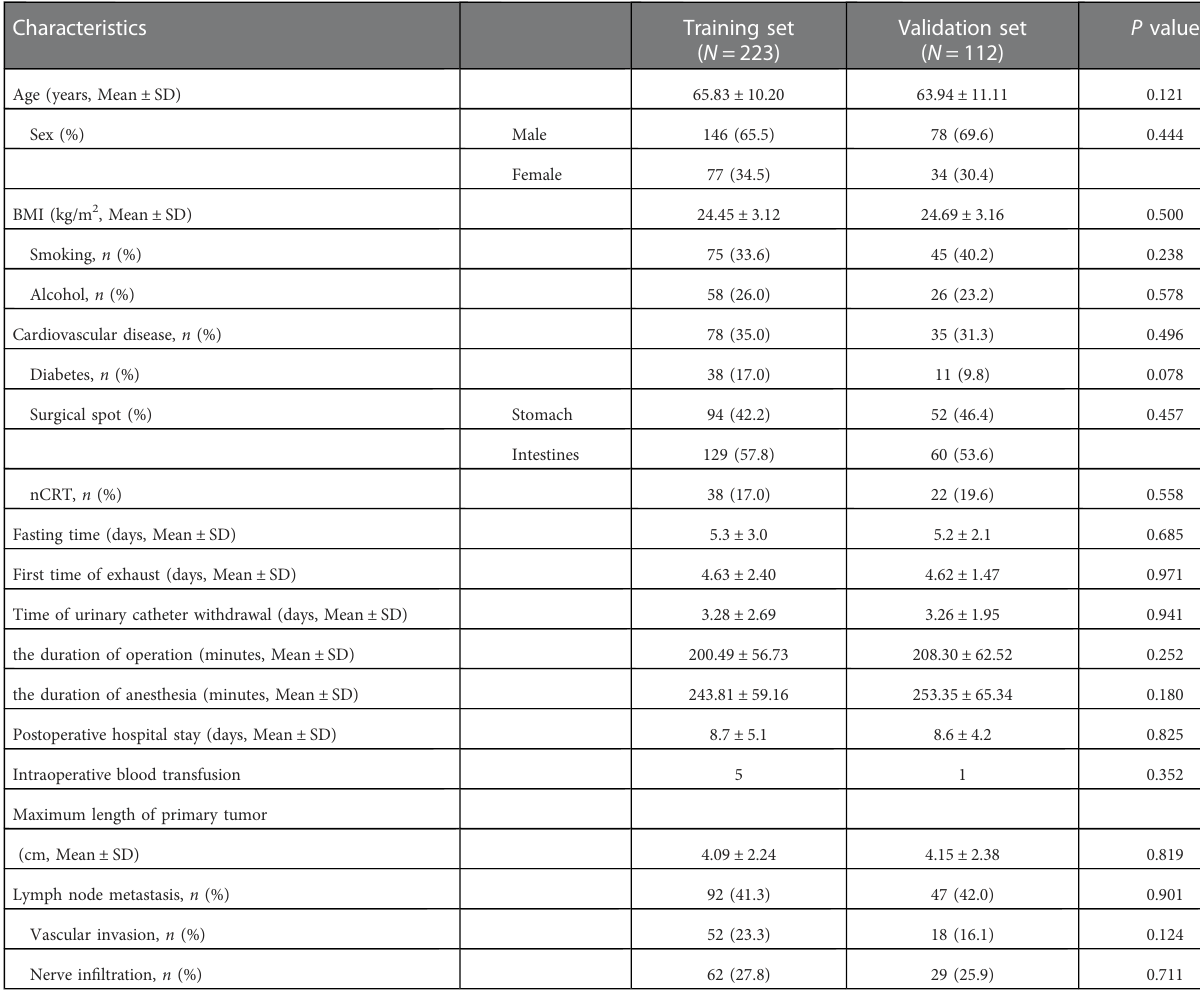
TABLE 1 Patient characteristics and short-term outcomes in the training and validation set.